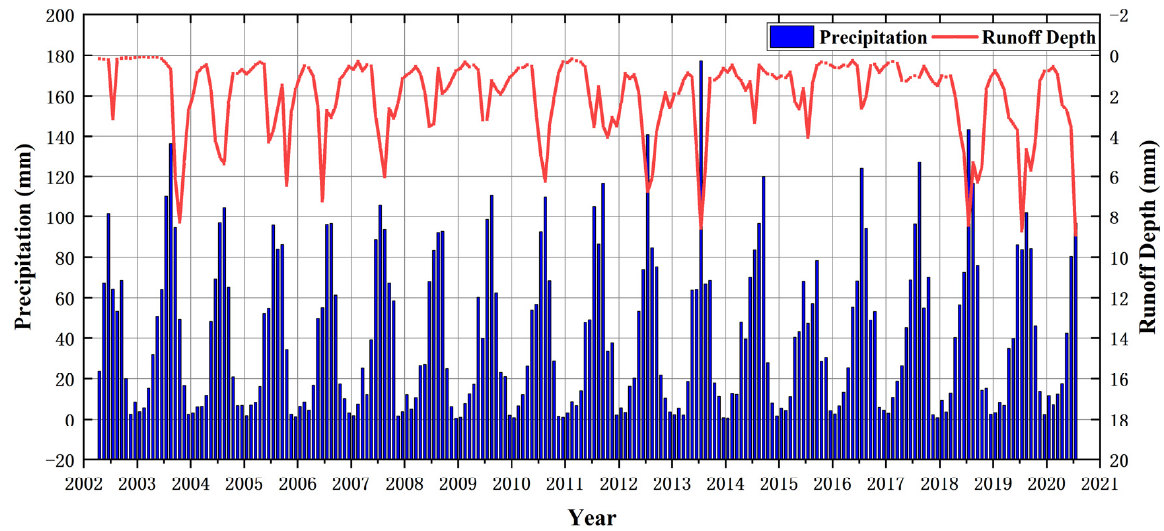
Figure 3. Time series of monthly precipitation and runoff depth in the Yellow River Basin.